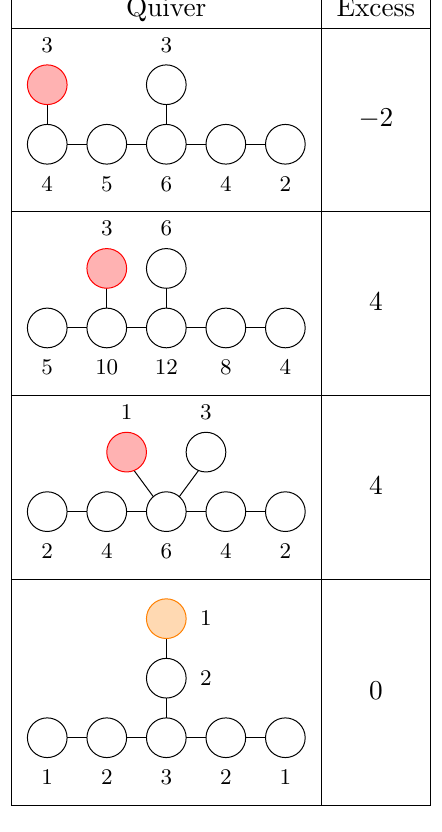
Table 4 . Minimally unbalanced quivers with G = E 6